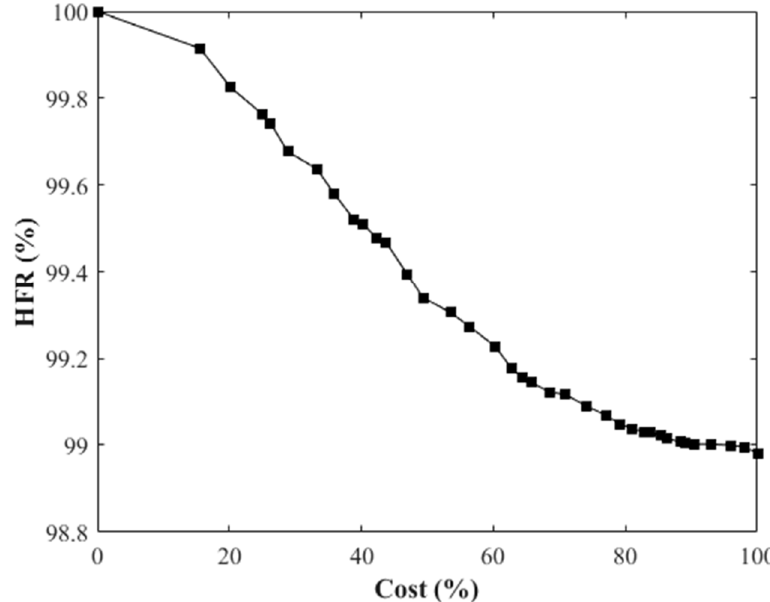
Figure 11. The Pareto frontier between the HFR and the cost.